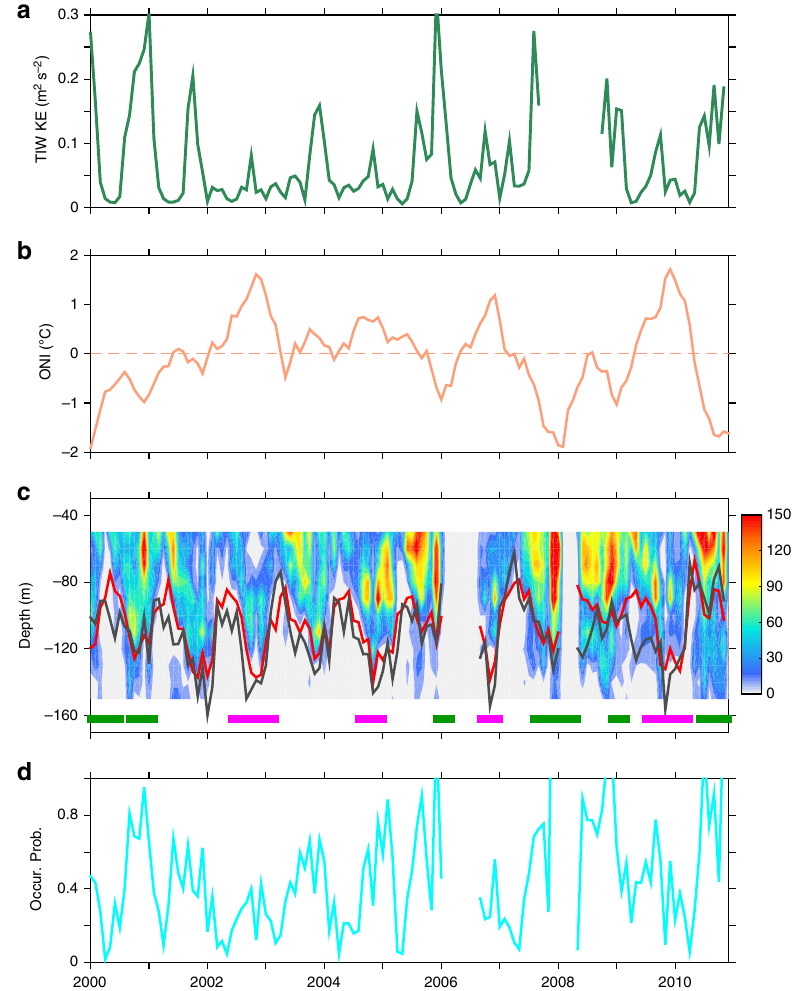
Figure 8 | Relation among instabilities, TIWs and large-scale processes on the inter-annual time scale. ( a ) Monthly TIW KE. ( b ) ONI, showing the Nin˜o 3.4 (5 (cid:2) S–5 (cid:2) N, 170–120 (cid:2) W) SSTanomaly (1981–2010 mean removed) calculated from v2 of the Optimum Interpolation Sea Surface Temperature (OISST). The dashed line denotes zero. ( c ) Monthly count of unstable modes in 10-m bins. The green and magenta bars on the bottom denote periods of the La Nin˜a and El Nin˜o conditions, defined when the ONI is r (cid:3) 0.5 (cid:2) C and Z 0.5 (cid:2) C, respectively. The red curve denotes the average depth of EUC core and the black curve denotes the average depth of the thermocline centre. ( d ) Monthly occurrence probability of unstable modes, defined as the ratio of counts of critical levels occurring between (cid:3) 50 and (cid:3) 150m of a month over the number of profiles of the given hourly temperature and velocity from TAO mooring at 0 (cid:2) , 140 (cid:2) W is interpolated (extrapolated if needed) at 1m spacing grids for both Ri calculation and the LSA (see below). As salinity observations of TAO are not sufficient and their contribution to density in this region is minor, salinity needed for real-time density calculation was often replaced by its temporal average 50 ; here we use the salinity climatology averaged from 251 Argo and CTD (CTD is obtained from the same source of Argo) profiles falling into the range of 0 (cid:2) ± 0.5 (cid:2) , 140 (cid:2) W ± 0.5 (cid:2) .